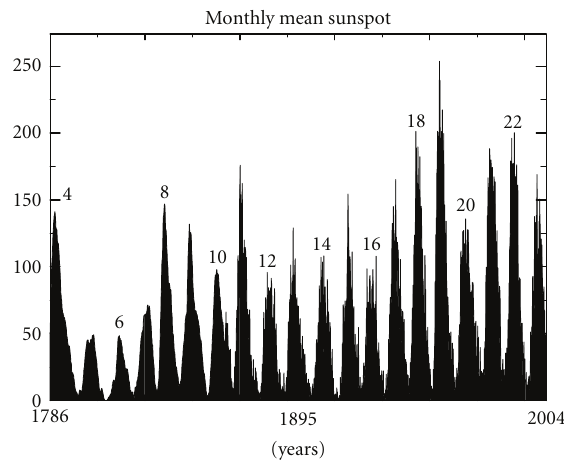
Figure 1: The sunspot cycle well documented over last 300 years shows a 11-year pattern of solar activity. Data from cycle 4 to cycle